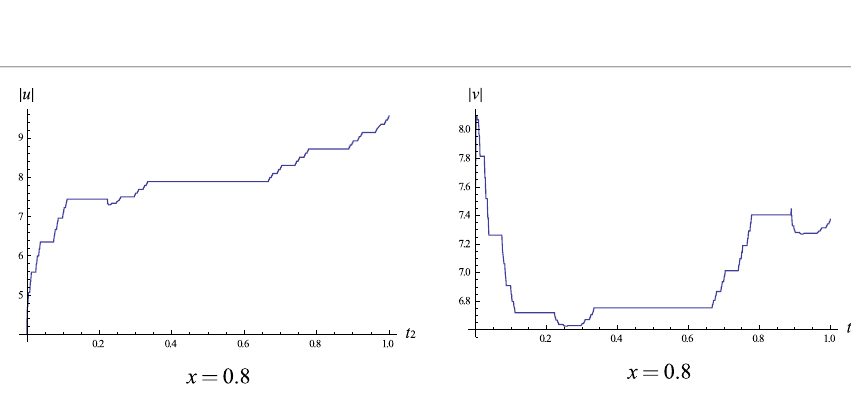
Figure 7 Space-time structures of two-fractal solutions (147) and (148) with α = ln2/ln3.